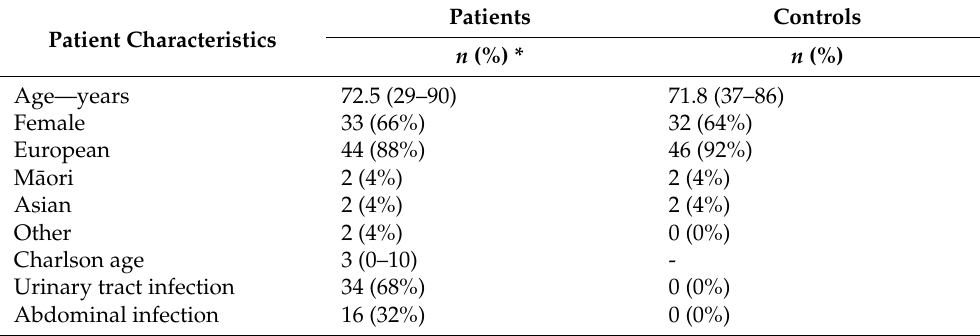
Table 1. Demographic characteristics of subjects admitted to Christchurch Hospital during the 2020–2021 study period. Data are expressed as the median with the interquartile range unless otherwise